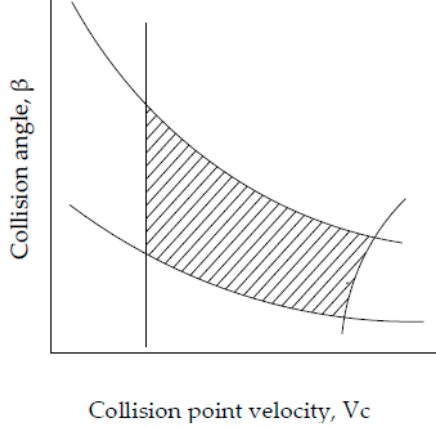
Figure 1. Weldability window for explosive welding.